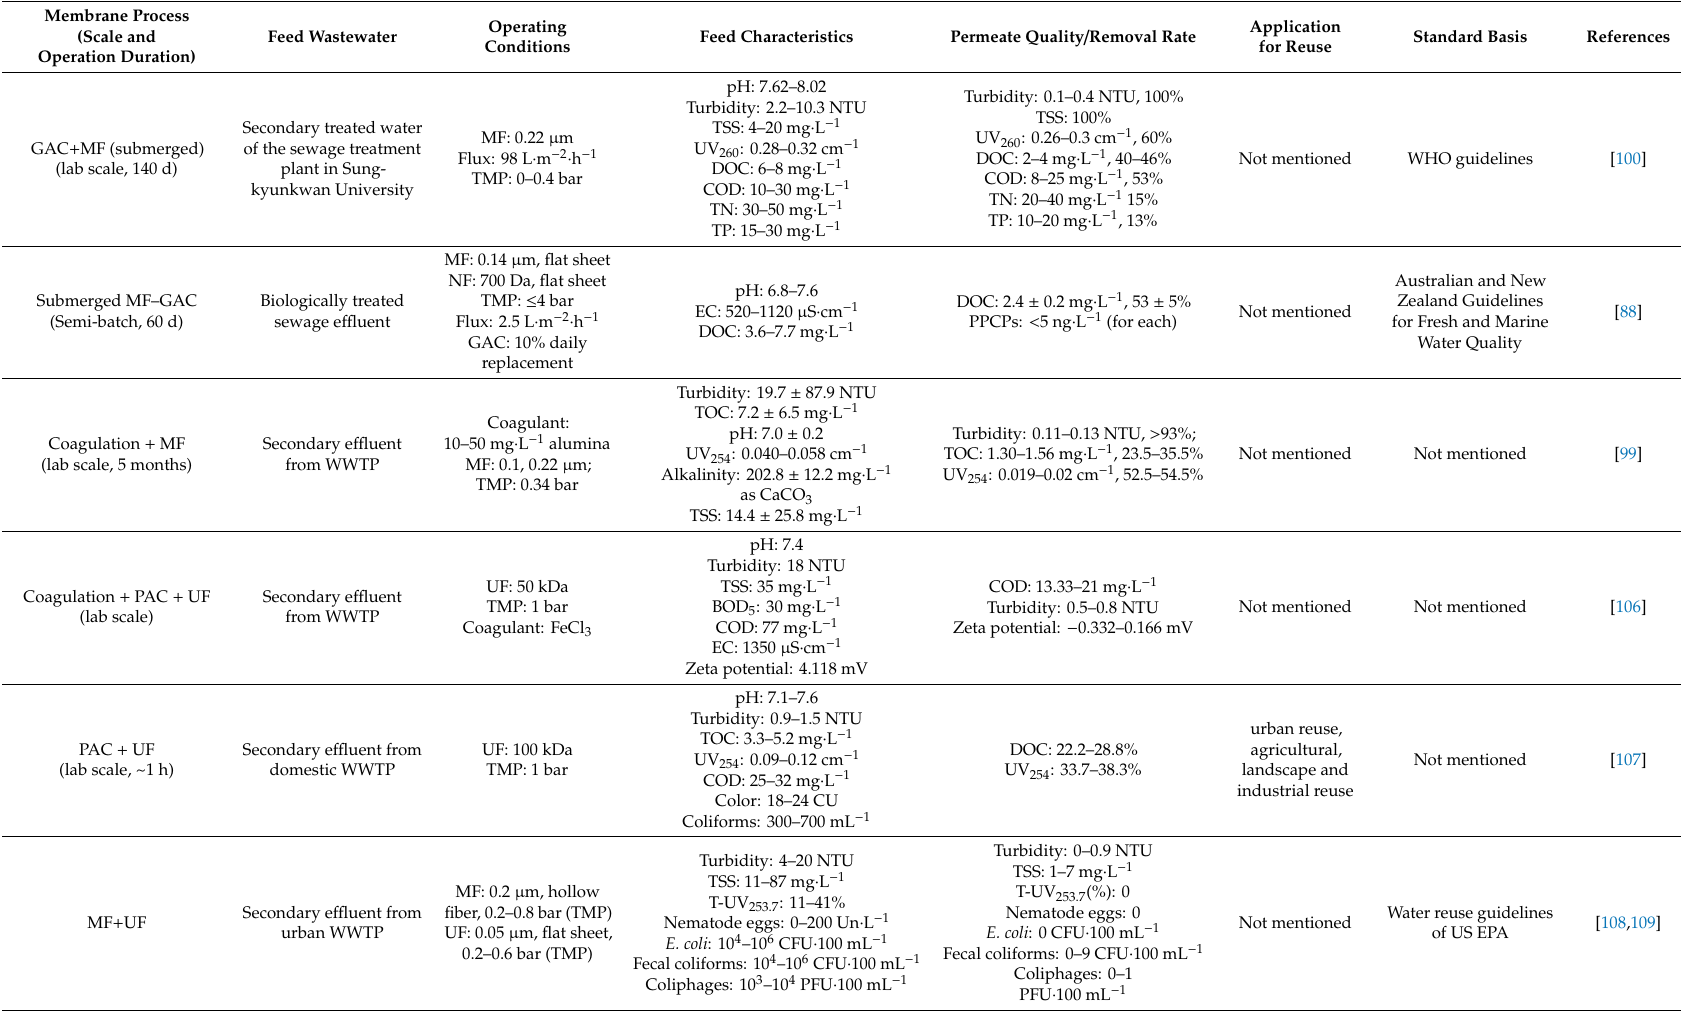
Table 7. Hybrid MF / UF membrane with chemical / physical processes after conventional secondary treatment for water reuse applications. Membrane Process (Scale